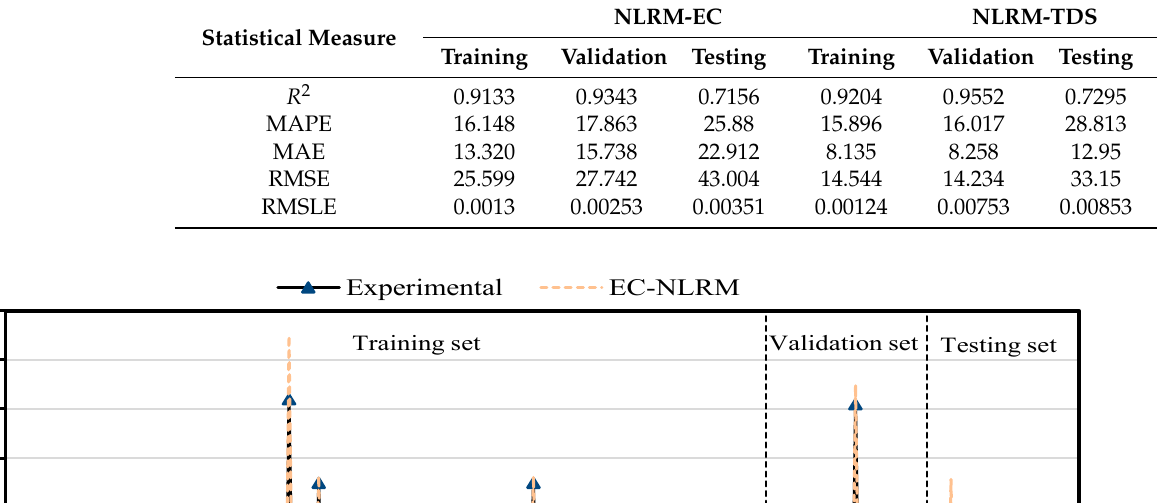
Table 6. Statistical error measurement of non-linear regression models developed for EC and TDS.